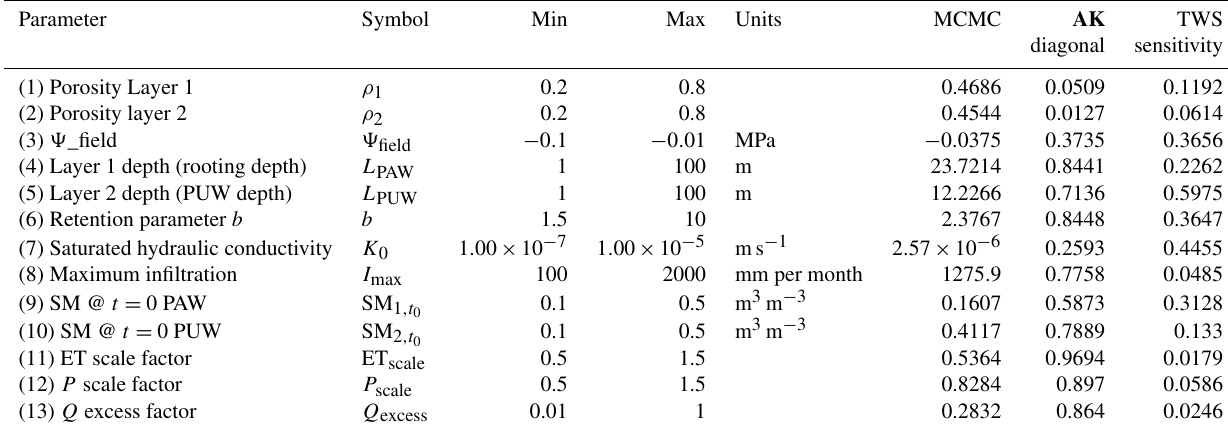
Figure 1. Model schematic for the data-constrained terrestrial water storage model. Arrows indicate the logical flow that describes the movement and storage of water in the model. The domain on the right highlights the western Amazonian watershed investigated in this study, the Gavião watershed. Table 1. Parameter estimation results for the Gavião watershed. Shown here are the model parameters and associated symbols, prior ranges (min–max), units, posterior solution median estimate (Markov chain Monte Carlo, MCMC), AK matrix diagonal values showing the level of uncertainty reduction (i.e., AK = 1 for full reduction, AK = 0 for no reduction in uncertainty), and TWS sensitivities ([mm change in TWS per 1%-unit change in parameter]) showing the sensitivity of TWS variability to model